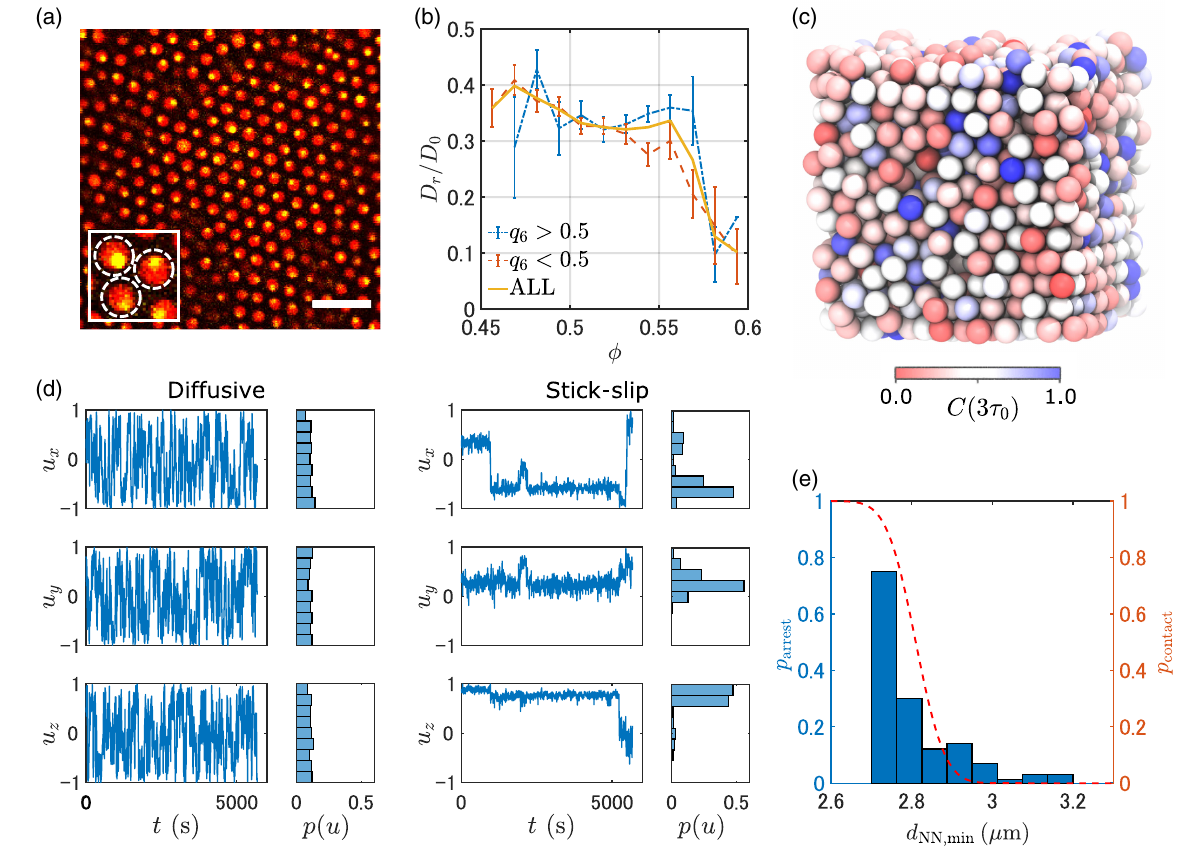
FIG. 4. Rotational motion in a partially crystalline sediment of core-shell OCULI particles. (a) Two-channel confocal image of core- shell OCULI particles. The scale bar is 10 μ m. Inset: zoomed-in portion with effective hard-sphere size indicated. (b) Rotational diffusivity of particles as a function of local volume fraction ϕ . Statistics are taken over three populations: crystalline particles ( q 6 > 0 . 5 ), amorphous particles ( q 6 < 0 . 5 ), and all particles. (c) Rendering of the particles in the region of interest, color coded by C ð 3 τ 0 Þ values: Red is for low, and blue is for high, scaled over the entire range 0 < C < 1 . (d) Unit orientation vector components u , u , x y u as a function of time for particles undergoing diffusive [ C ð 3 τ 0 Þ ≈ 0 . 06 , left] and stick-slip [ C ð 3 τ 0 Þ > 0 . 9 , right] rotational motion, and z ¼ p ð C ð 3 τ Þ > 0 . 9 Þ , and the probability of two particles their histograms. (e) Probability of a particle being rotationally arrested, p 0 arrest being in contact at a particle separation, p contact